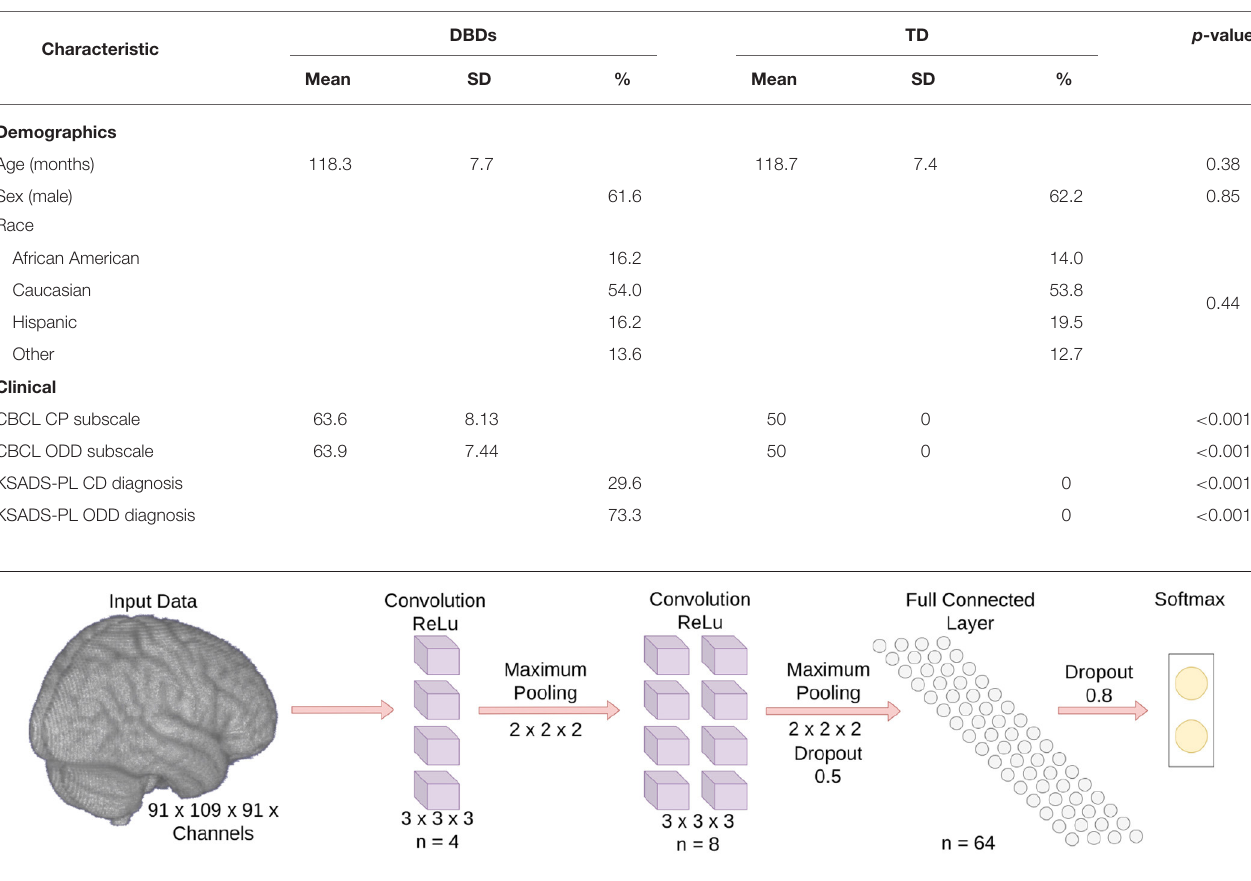
TABLE 1 | Demographic and clinical characteristics of the study pool.